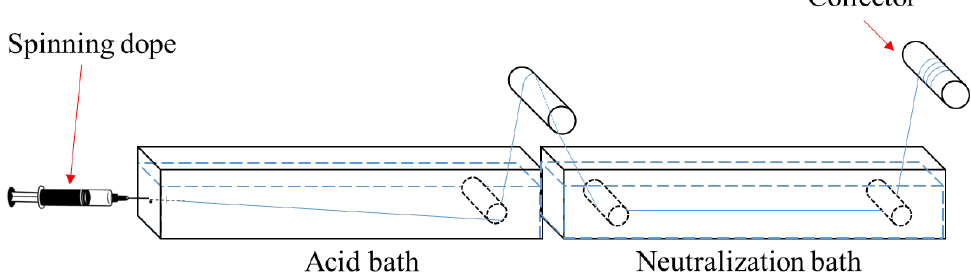
Figure 1. Illustration of in-house wet-spinning setup.